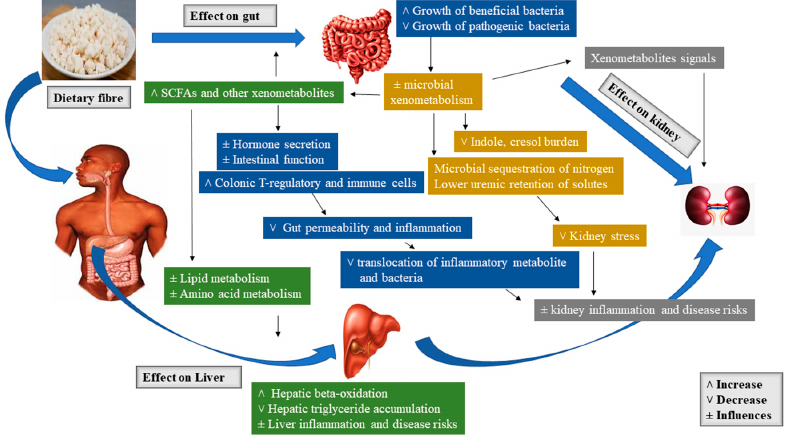
Figure 2. Schematic overview of the major prebiotic effects of dietary fiber on gut, liver, and kidney.